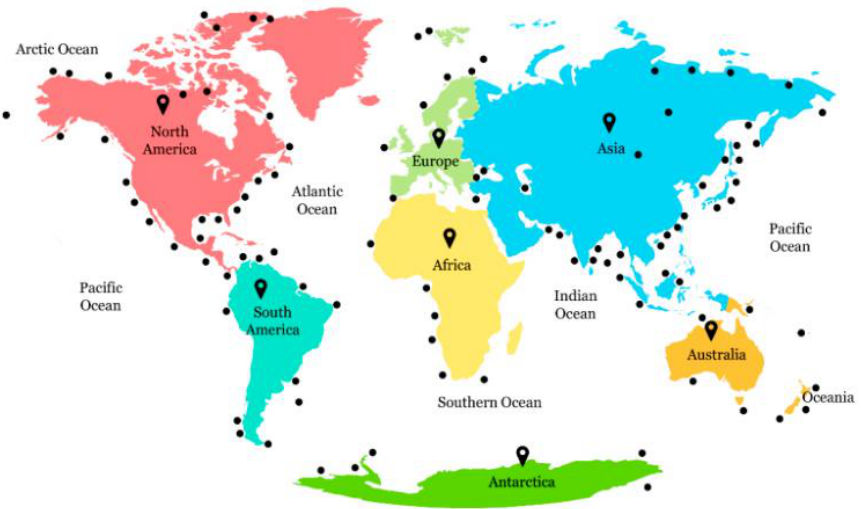
Figure 1. Natural gas hydrate distribution around the world [This figure was modified with permission from ref. [7]. Copyright 2009, Elsevier].